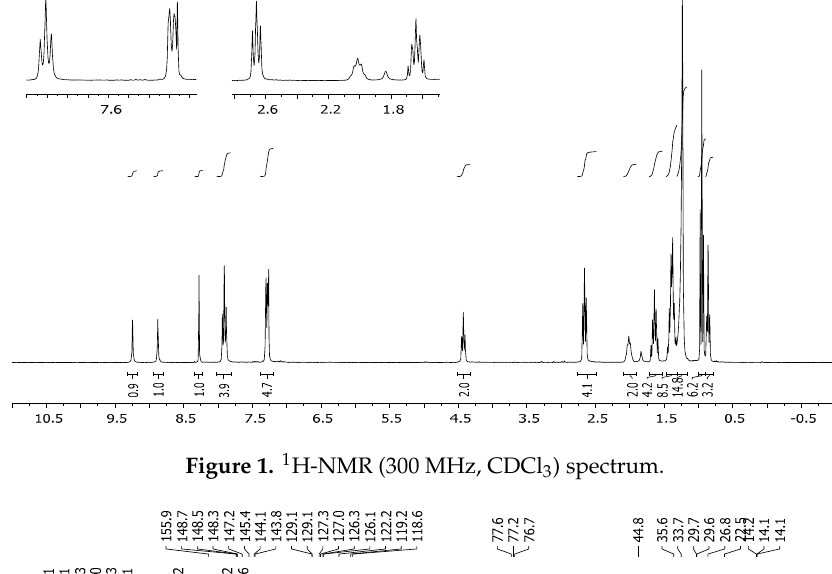
Figure 1. 1 H-NMR (300 MHz, CDCl 3 ) spectrum.